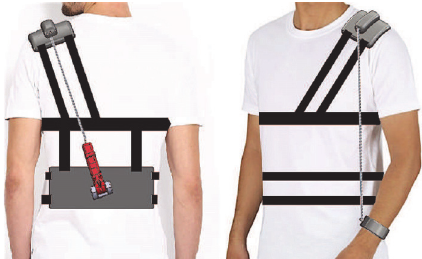
Figure 1: Conceptual view of an elbow assistive device based on the twisted string actuation